Question: Draft a figure caption describing what is shown.
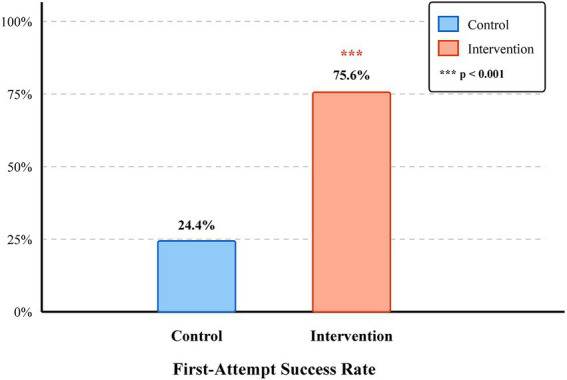
Answer: Comparison of first-attempt success rate and MBCT positivity rate. The intervention group showed a higher first-attempt maneuver success rate, whereas the MBCT positivity rate did not differ significantly between groups.